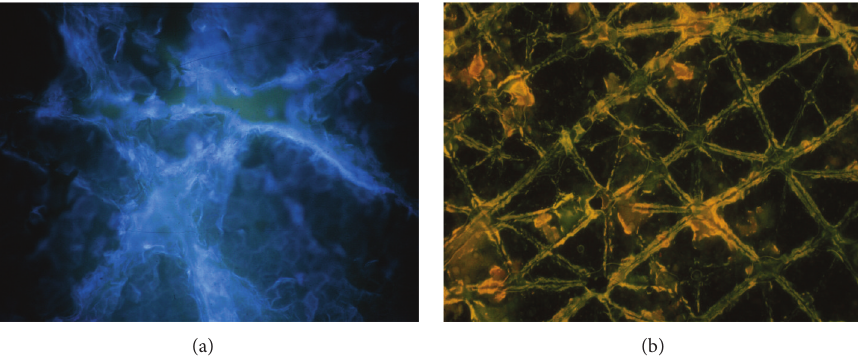
Figure 9: Persisting fluorescence of the stratum corneum. (a) Uneven fluorescence. (b) Persisting fluorescence of the shallow